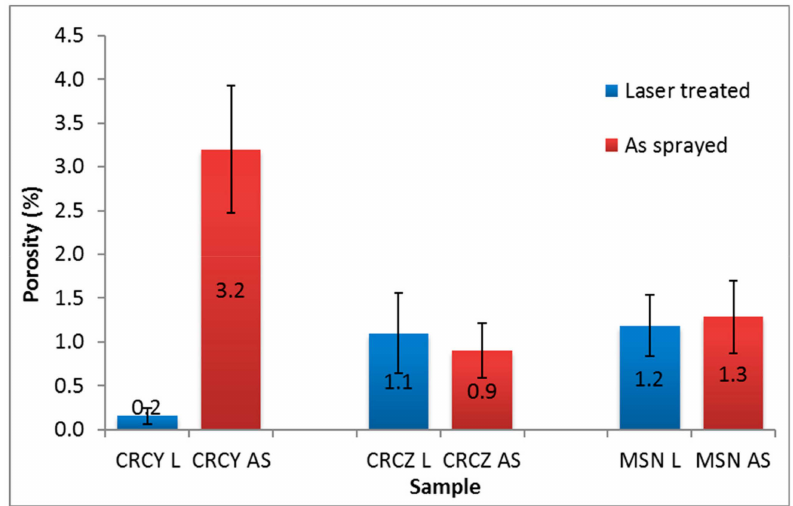
Figure 7. Porosity of the as-sprayed (AS) and laser-treated (L) samples. (error bars indicate +/ − standard deviation).